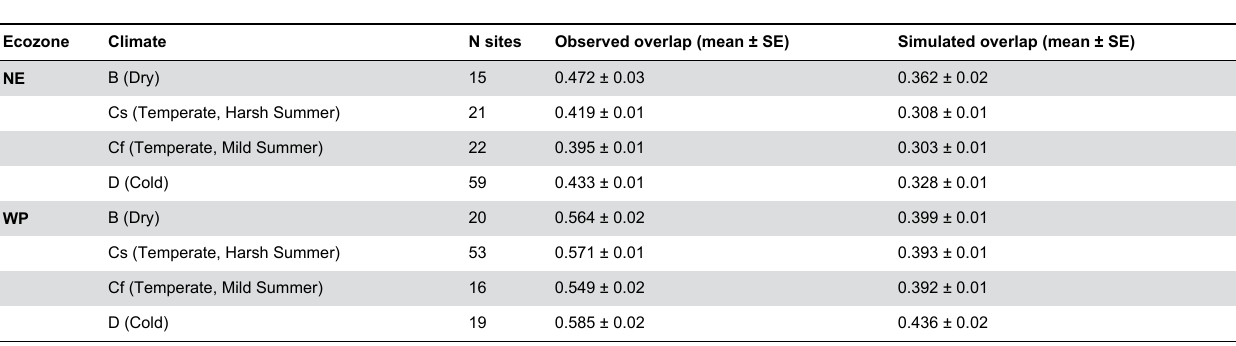
The observed functional overlap for each of the 225 studied wetlands was significantly higher than expected (p < 0.05). This table summarizes results for wetlands falling under the same climate and ecozone. Observed overlap = niche overlap values averaged across wetlands under the same climate and ecozone; Simulated overlap = niche overlap values simulated by the null models, averaged across wetlands under the same climate and